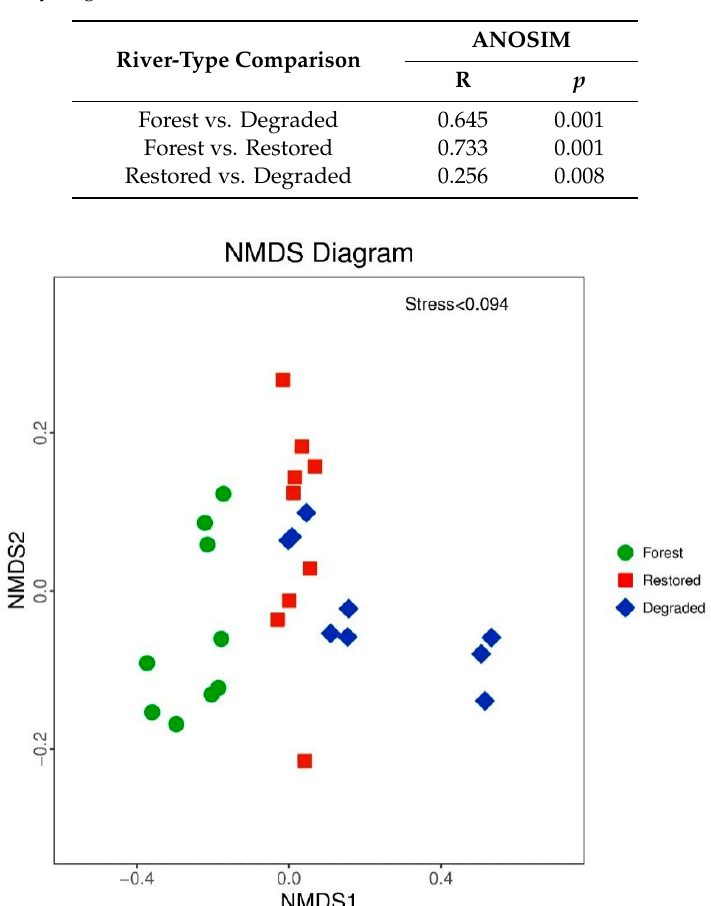
Table 3. Analysis of similarities (ANOSIM) of biofilm bacterial communities in contrasting river types within the Anji City Region, PRC.